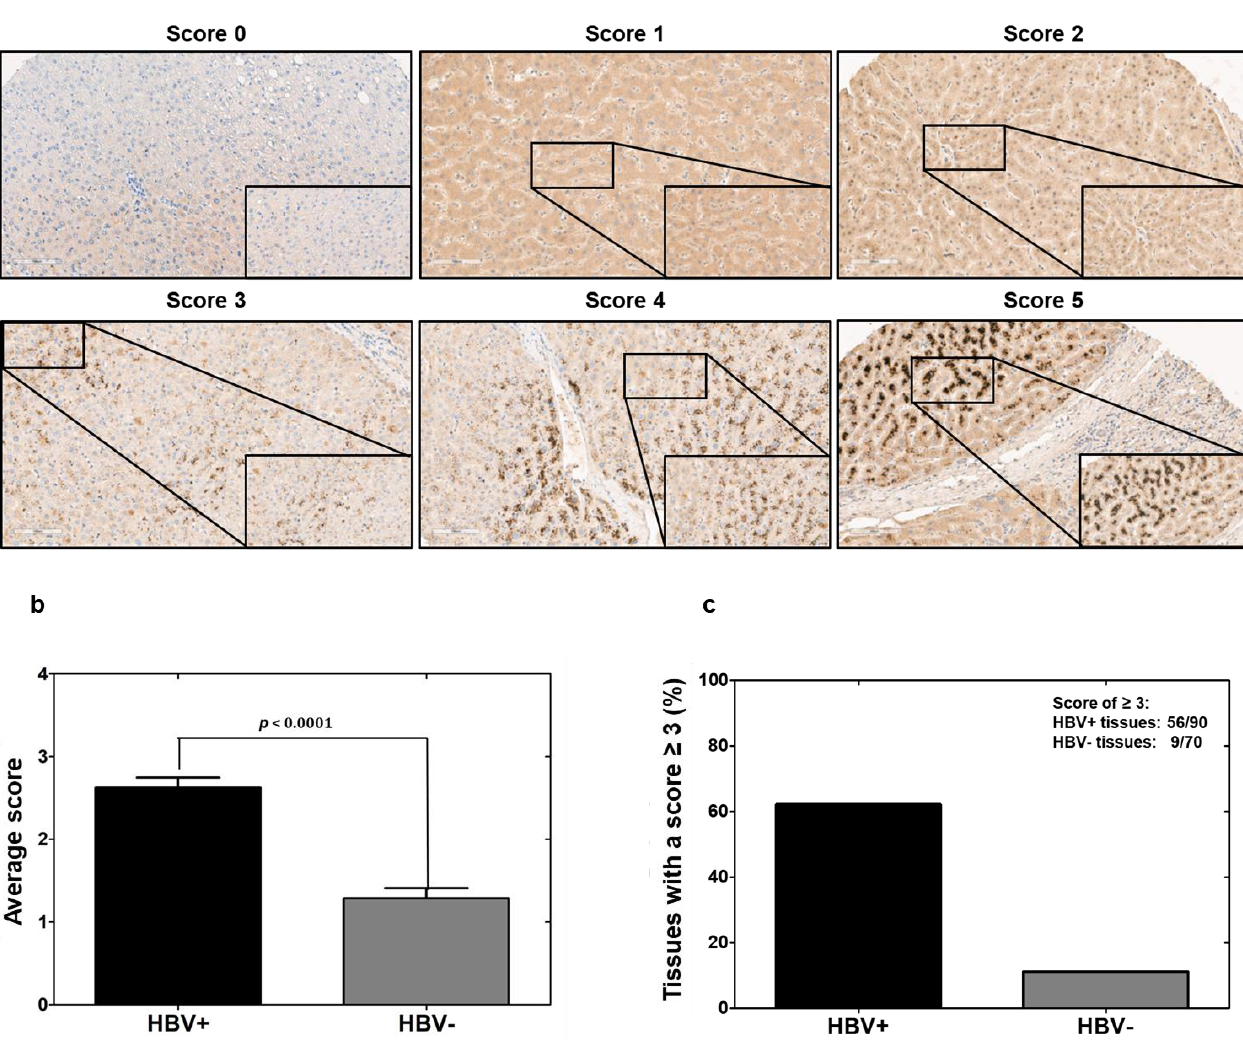
Figure 4. The presence of vi-VIM is significantly increased in HBV-infected liver. ( a ) A human liver tissue array was stained with mVSF by IHC and the staining intensity and distribution of antibody-bound vi-VIM were scored on a 0–5 scale. ( b ) Comparison of the average scores between HBV-uninfected and -infected liver tissues. ( c ) Comparison of percentages of HBV-uninfected and - infected liver tissues with a score of ≥3.